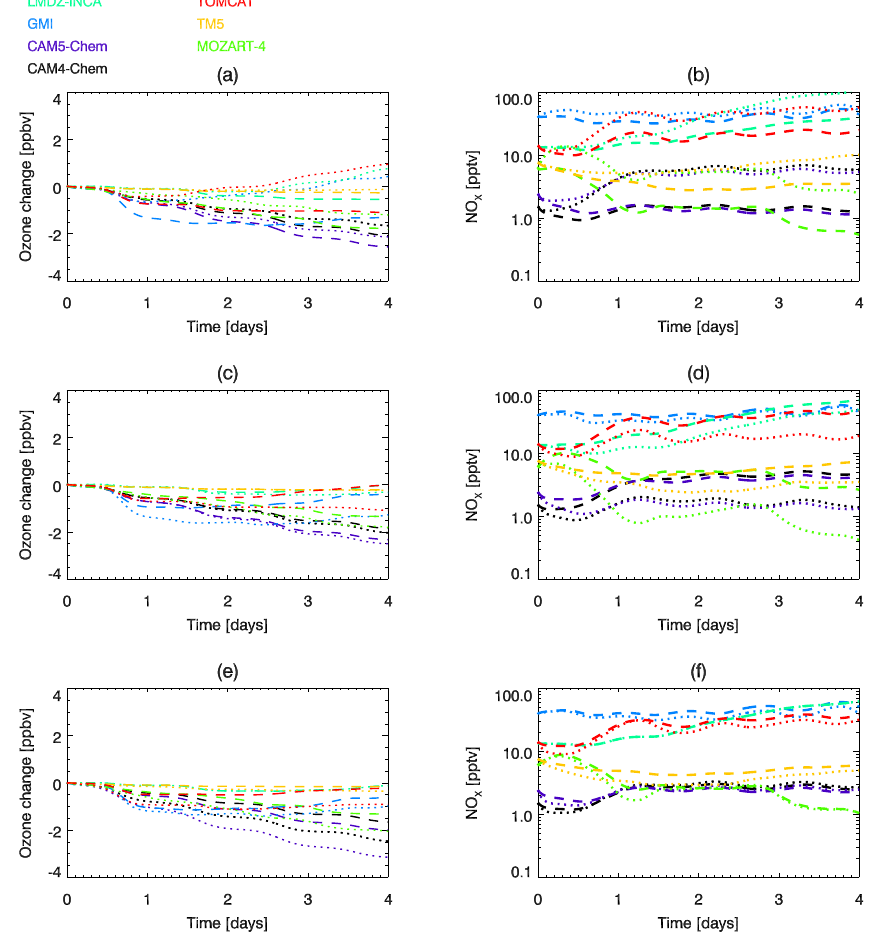
Figure 14. CiTTyCAT Lagrangian box model simulations showing sensitivity of fire plume ozone and NO x evolution in the Arctic to initial concentrations of key species. Dotted and dashed lines show simulations initialized with 200 and 50%, respectively, of PAN ( a–b ), acetone and acetaldehyde ( c–d ), H 2 O 2 and CH 3 OOH ( e–f ). Ozone change from simulations with unperturbed initial concentrations are shown in Fig.